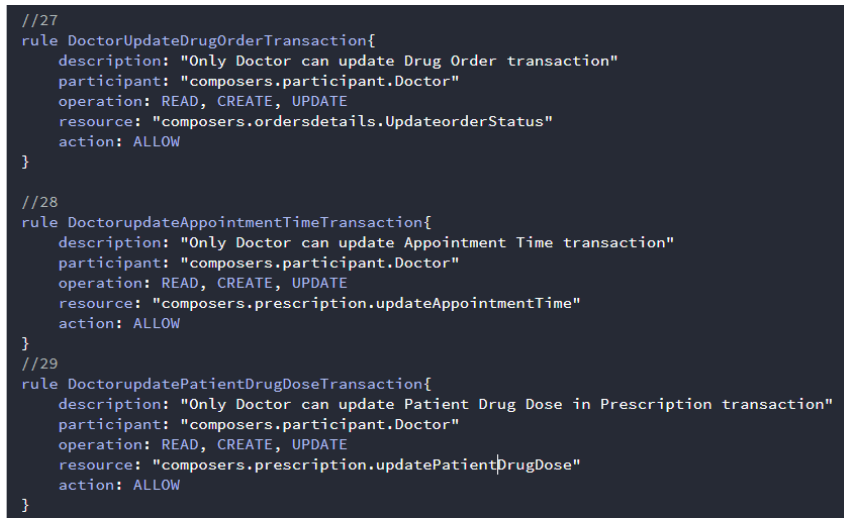
Figure 11. Access control definition in the proposed drug supply chain management in a medical blockchain platform.